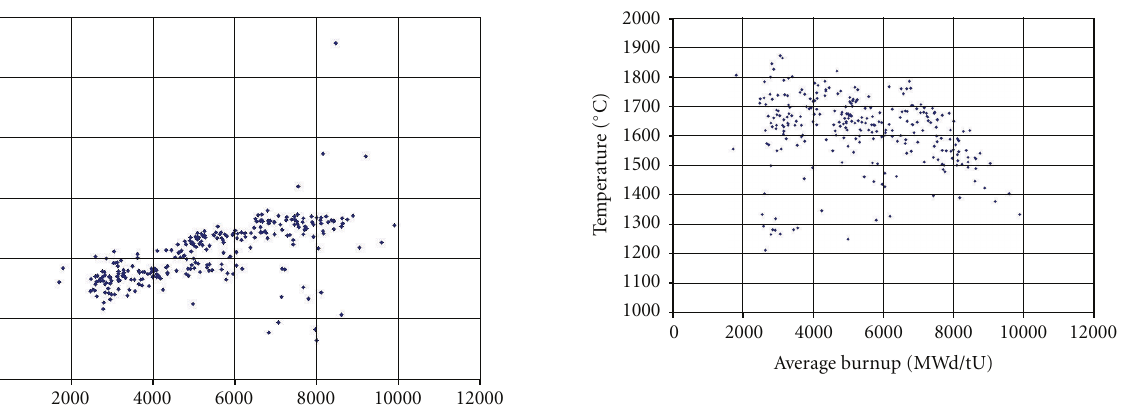
Figure 4: Pellet centre temperature for each fuel of the first SEU core of the Atucha 1